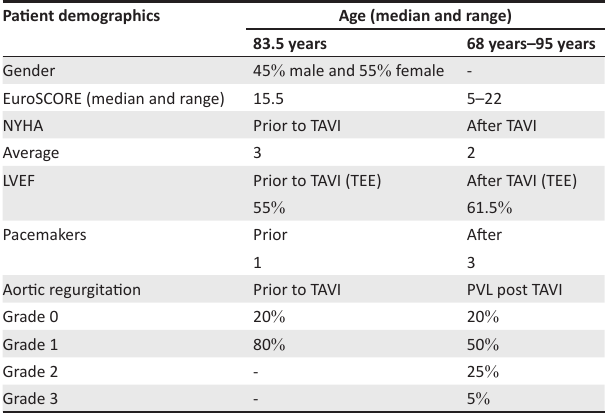
FIGURE 2: FACTS and Rosenhek scores v.